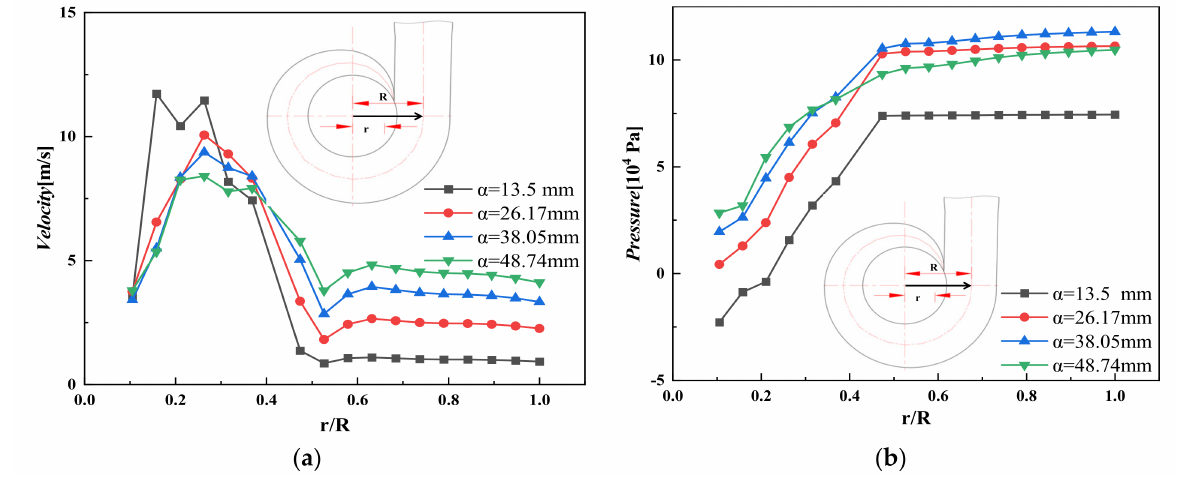
Figure 8. Comparison of pressure and velocity with the increasing relative diameter at meridional section of spiral case. ( a ) Velocity curve; ( b ) Pressure